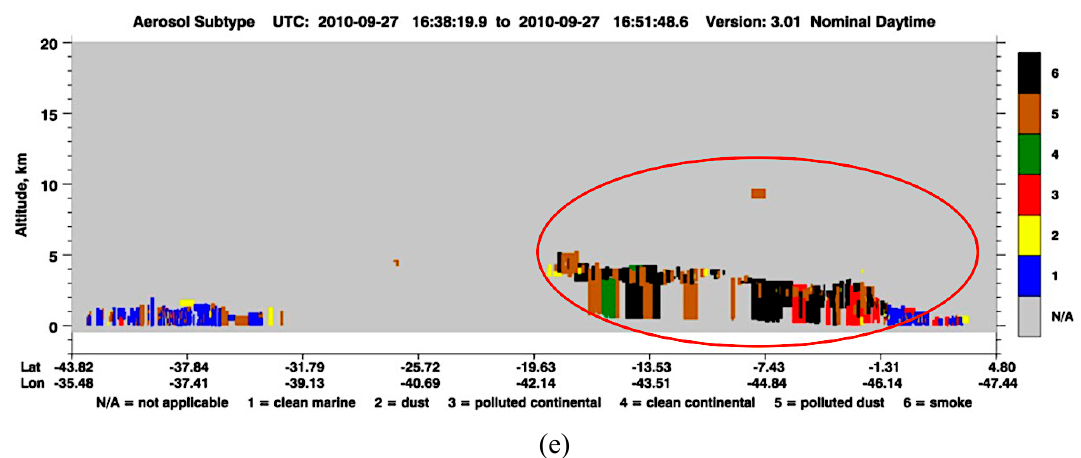
Figure 8. Case study CS-1 on 27 September 2010. MODIS AOD at 550 nm derived from AQUA and TERRA satellites. ( a ) Northwest Africa, the Atlantic Ocean and NEB, ( b ) NEB, ( c ) and ( d ) show the 10 and 12-day simulations of HYSPLIT backwards trajectories, respectively, ending over the state of Maranhão on 30 September 2010 at 13UTC. The red backward trajectory corresponds to 500 m, blue to 1500 m and green to 2500 m height. ( e ) presents the aerosol subtype for September 27 displaying the presence of (1) clean marine (in blue), (2) dust (in yellow), (3) polluted continental (in red), (4) clean continental (in green), (5) polluted dust (in brown) and (6) smoke (in black) aerosols.